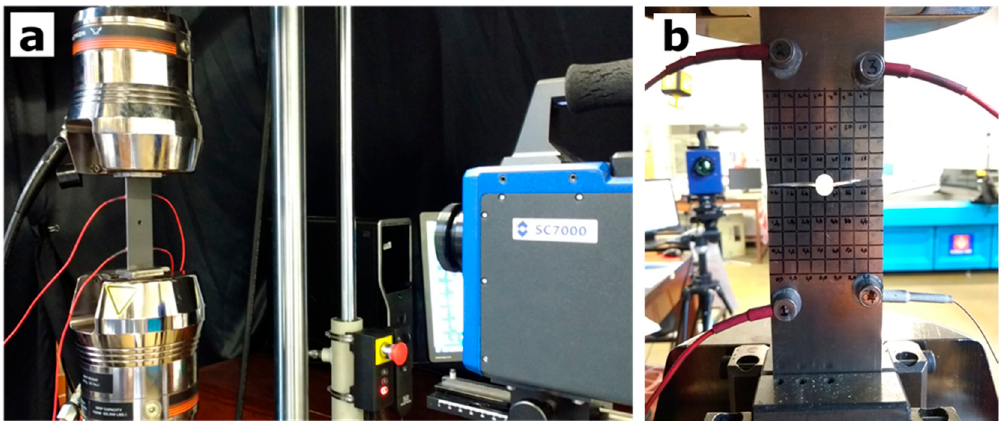
Figure 1. Experimental set-up: ( a ) From front (thermoelastic stress analysis (TSA) data collection) and ( b ) back (acoustic emission (AE) data collection). Specimen width is 40 mm.